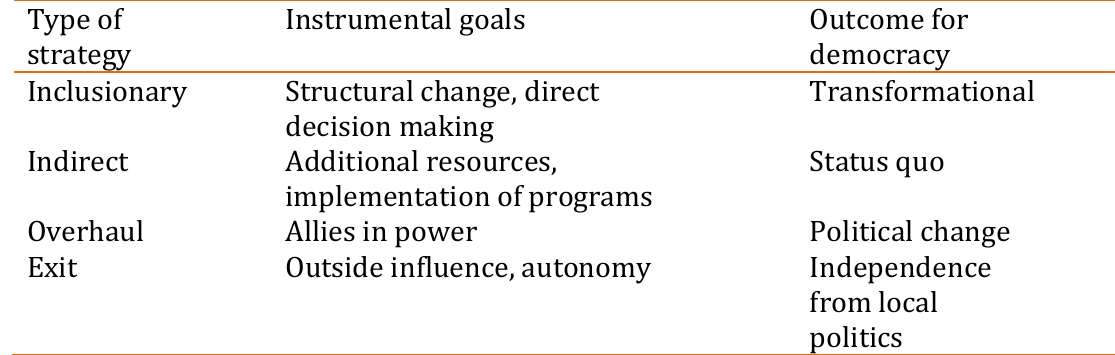
democracy Transformational Status quo from local